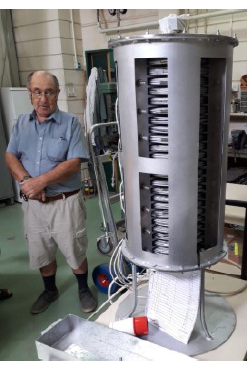
Fig. 7. A picture of the high temperature (300 o C) liquid Lithium ALIN